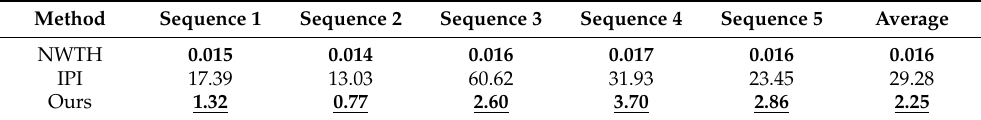
Table 5. Average processing time of a single frame (notation: best result, second-best